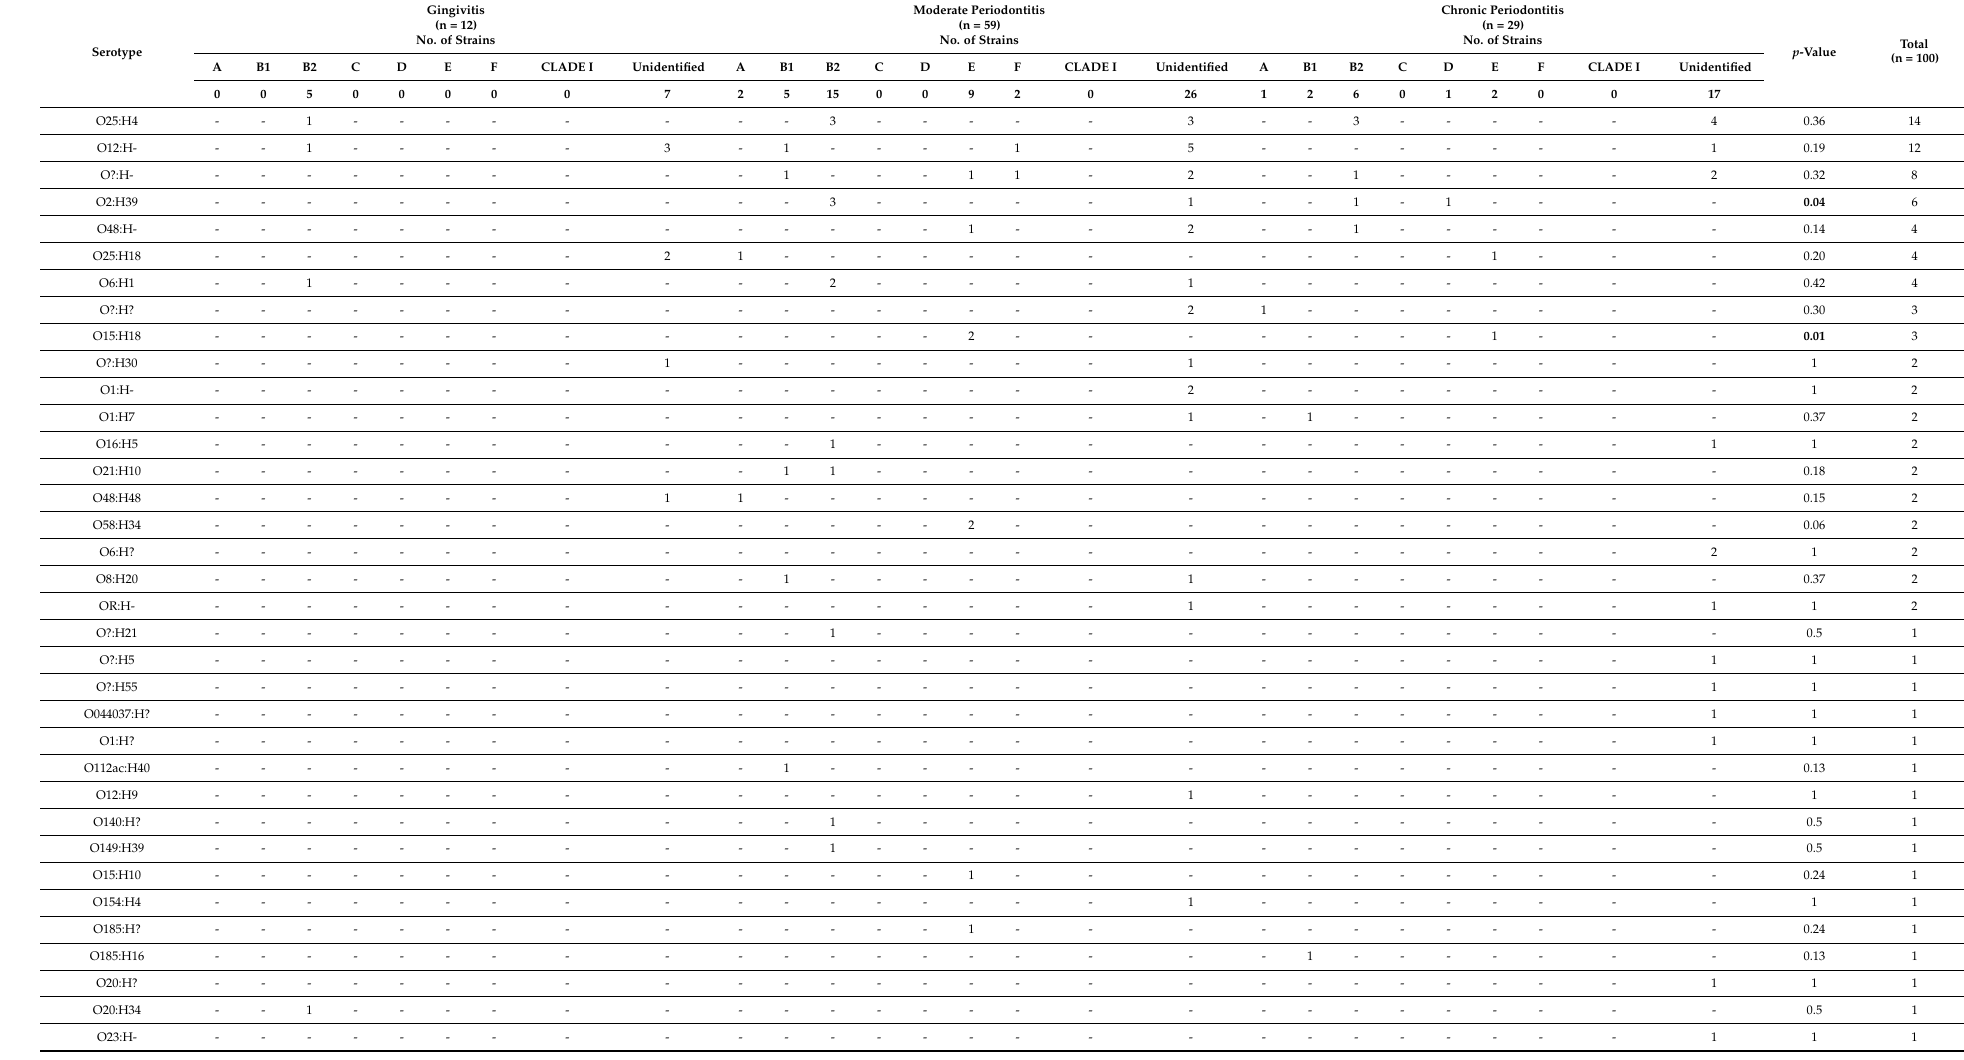
Table 5. Frequency of the serotypes according to phylogroups in the E. coli strains.